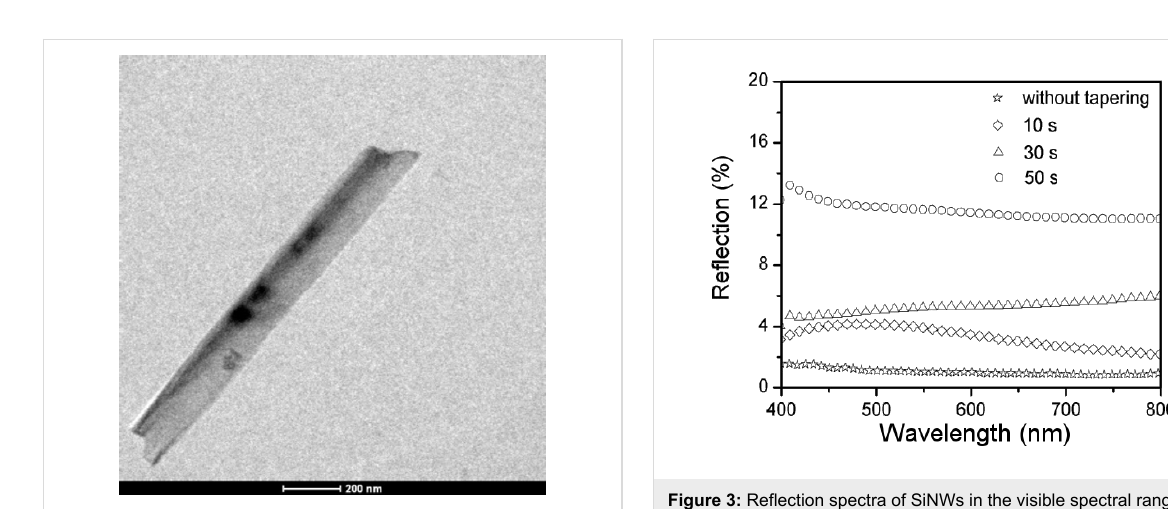
Figure 1: Tilted-view, SEM observations of SiNW samples without tapering (a) and for different tapering times: (b) 10 s, (c) 30 s, (d) 50 s.